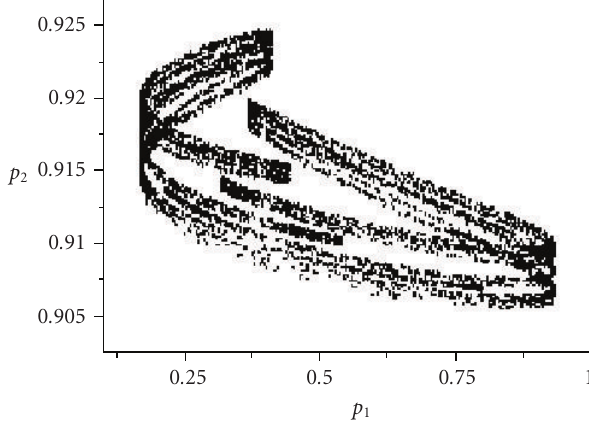
Figure 4.4 . Strange attractor for α 2 = 0 . 07.